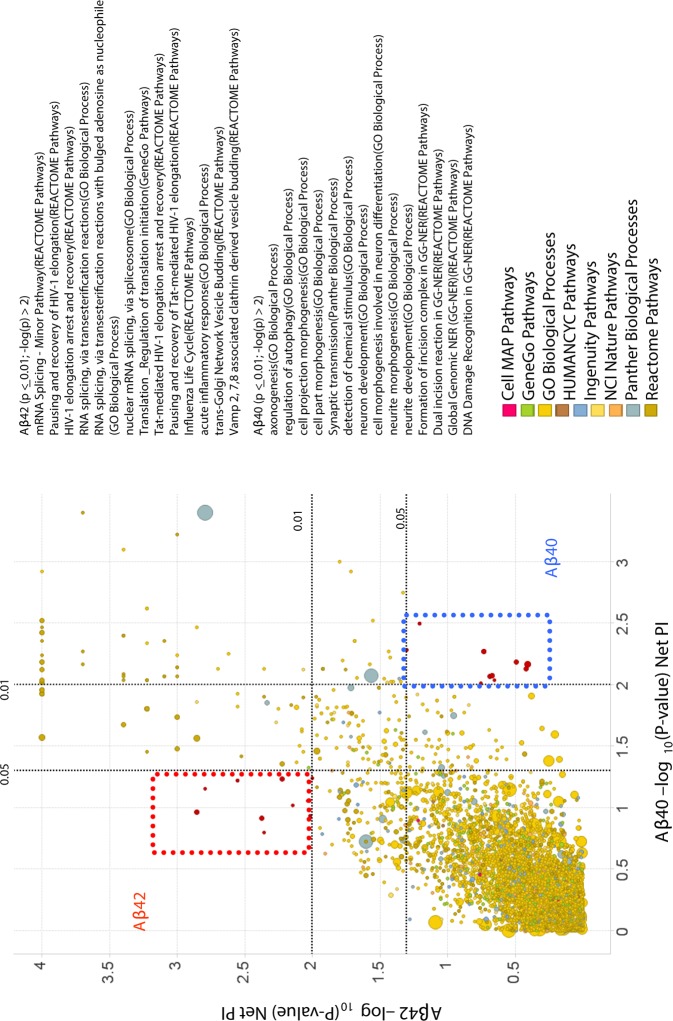
Pathways/processes that differentially regulate Aβ42 vs. Aβ40 production.A. Scatter plot of -log(-P-values) for Net PI scores of pathways/processes for Aβ42 against that for Aβ40. Each circle represents a pathway/process. The size of the circle corresponds to the number of genes in the set. The color corresponds to the database source from which the pathway/process was derived. As expected, most pathways and processes that regulate Aβ40 also regulate Aβ42 production. However, there are some “modulator” pathways that are significant for one readout but not the other. Red square: Aβ42-regulating pathways. Blue square: Aβ40-specific pathways.